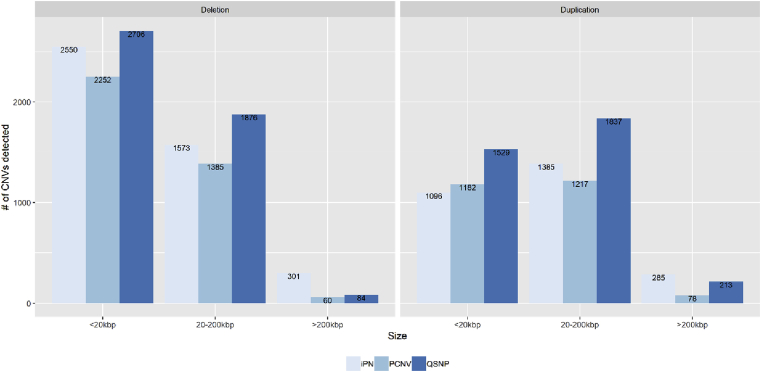
Number of CNVs detected by different algorithms for each size group. Labels inside the bars indicate the exact number of CNVs detected for each category after sample and CNV quality control but before CNV merging. In the legends, iPN = iPattern; PCNV = PennCNV; and QSNP = QuantiSNP.